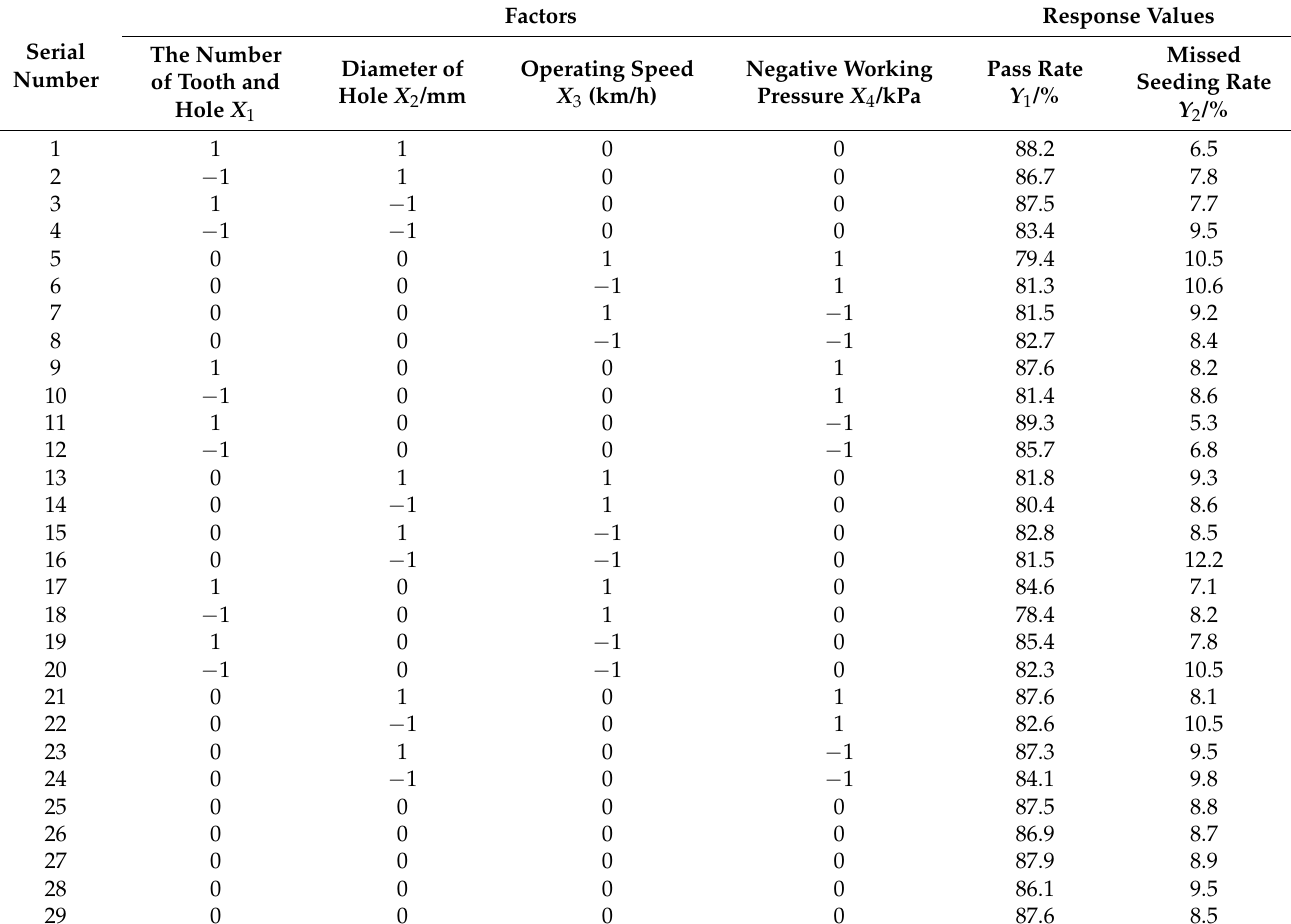
Table 5. Experimental design and